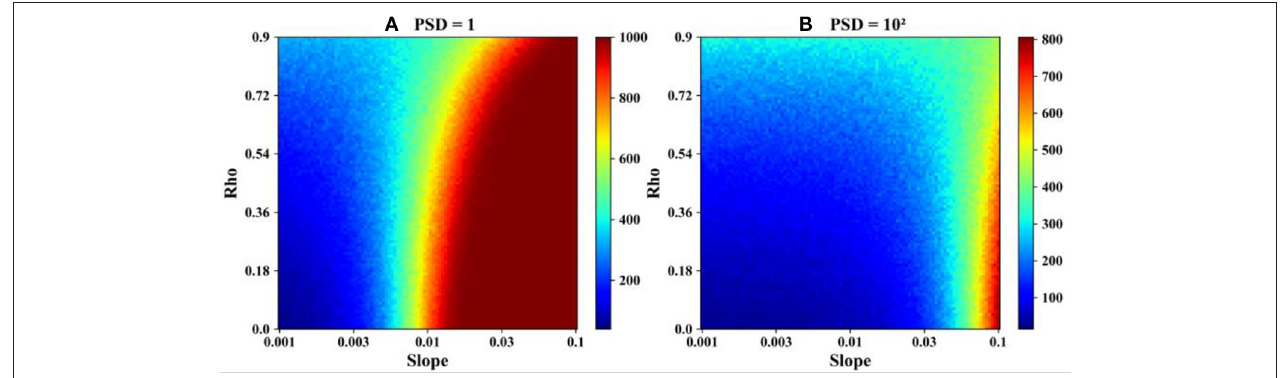
FIGURE 11 | Heat map of the rejection rate with different combinations of slope values and serial correlation values, where the sample length is 100 and PSD values are equal to 1 and 100 respectively. (A) PSD